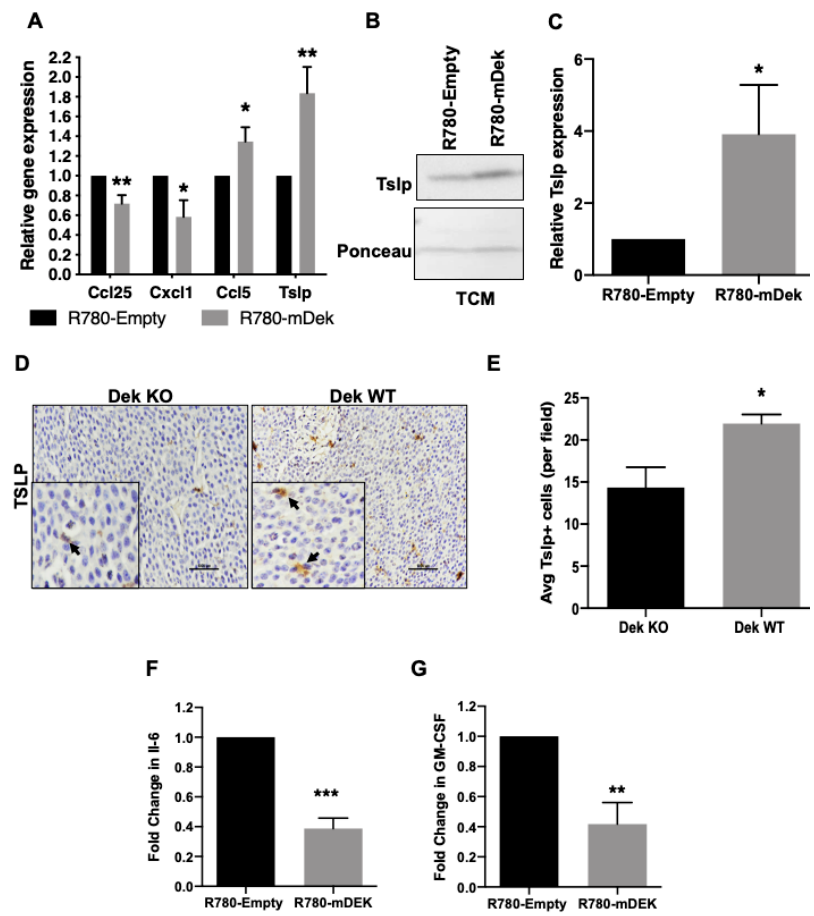
Figure 2. Cytokines associated with macrophage polarization and tumor-immune responses are deregulated with Dek expression. ( A ) mRNA levels of Ccl25 and Cxcl1 are down-regulated while Ccl5 and Tslp are upregulated in Dek expressing RD147 cells as determined by quantitative RT-PCR ( n = 3). ( B ) Western blot analysis shows Tslp protein is upregulated and secreted into tumor conditioned media (TCM) in Dek expressing cells and the quantitative densitometry is depicted in ( C ) n = 3. ( D ) Immunohistochemistry staining of Tslp was performed on primary mammary tumors from Ron tg Dek KO (left) and WT (right) mice. ( E ) Quantification of ( D ), showing increased numbers of Tslp positive cells per field in Dek WT tumors compared to KO tumors, n = 6 tumors from different mice per genotype. ( F,G ) The downregulation of IL-6 ( F ) and GM-CSF protein ( G ) in R780-mDEK cells compared to R780-Empty cells was determined by a Luminex immunoassay. n = 3 independently generated cell lines (RD147, RD219, RD238). * indicates p -value < 0.05, ** indicates p < 0.01 and *** indicates p < 0.00 using Student’s t -test.